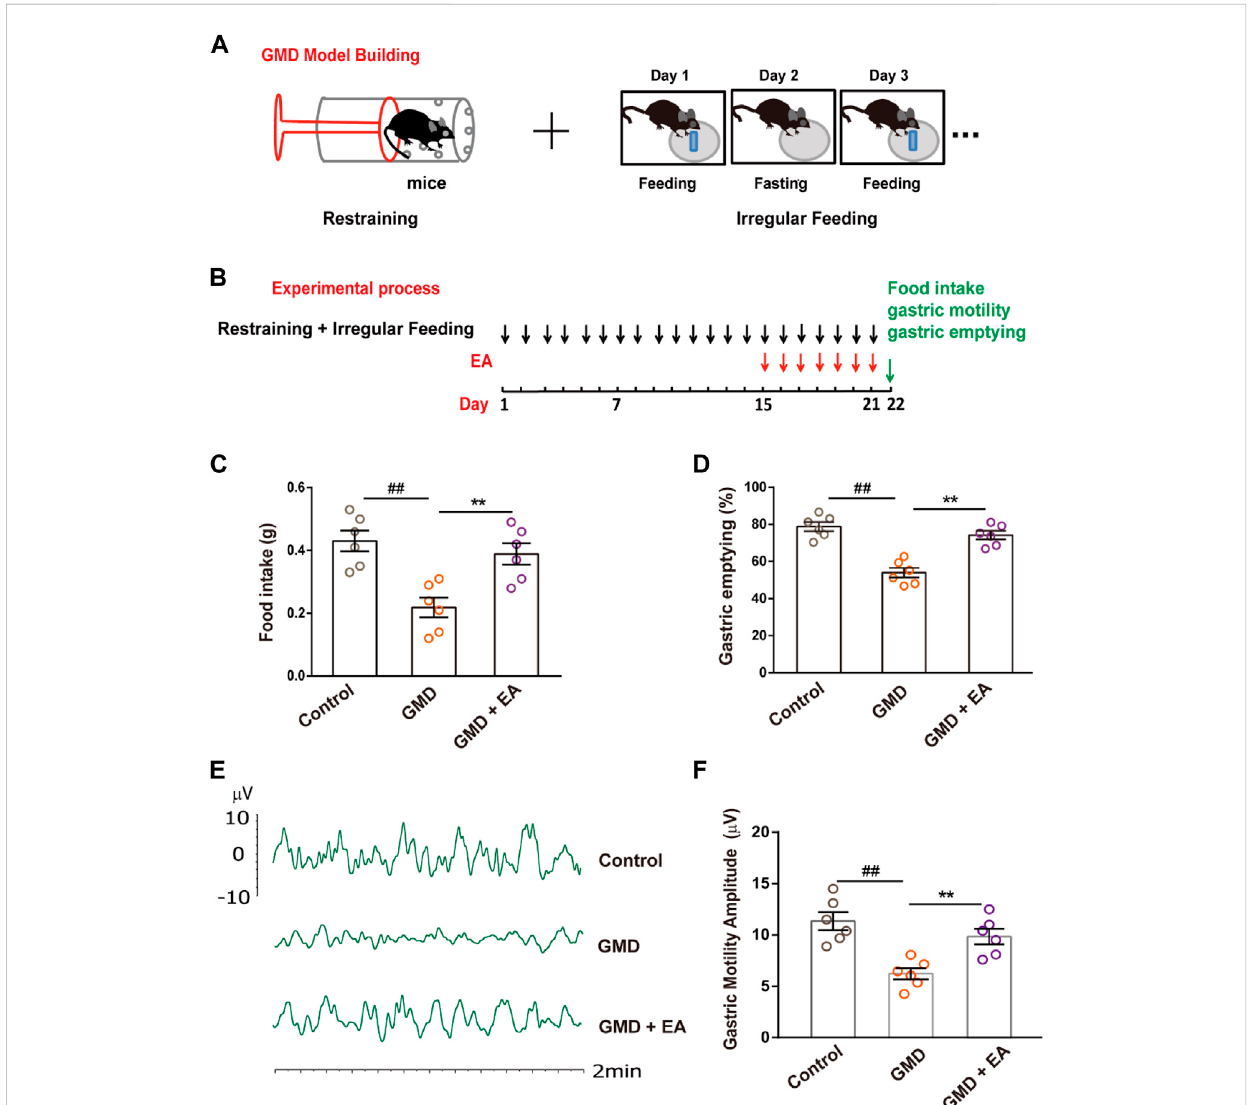
FIGURE 1 The effect of RS and EA on gastric motility . (A) GMD model building; (B) An outline of the experimental procedure in GMD mice. (C – F) Gastric function tests of food intake, gastric emptying, and gastric motility. ( n = 6 mice per group). All data are presented as the mean ± SEM. ## p < 0.01, ** p < 0.01, one-way ANOVA for (C , D, F)